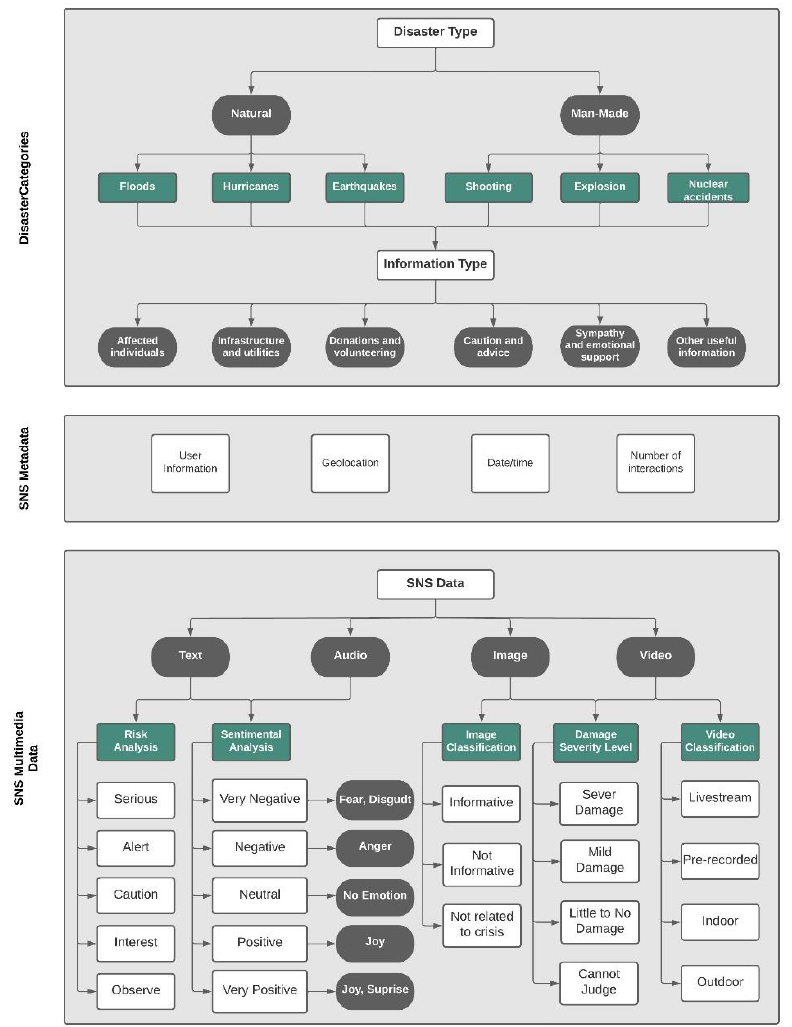
Figure 3. A summary of required disaster-related data collection from social media and their classi- fications.